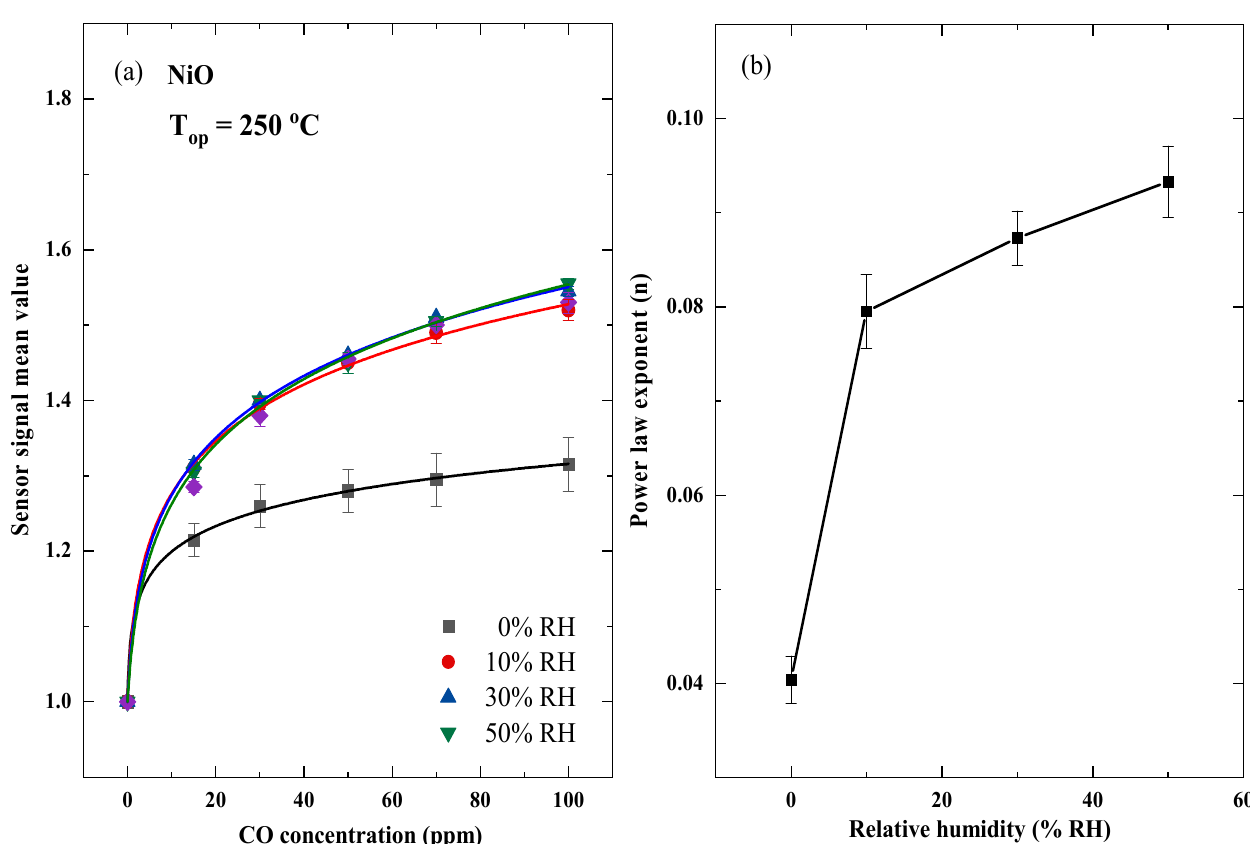
Figure 5. The mean value of the sensor signal dependence with respect to the CO concentration when operated under different %RH ( a ); the influence of the RH on the power-law exponents ( b ).